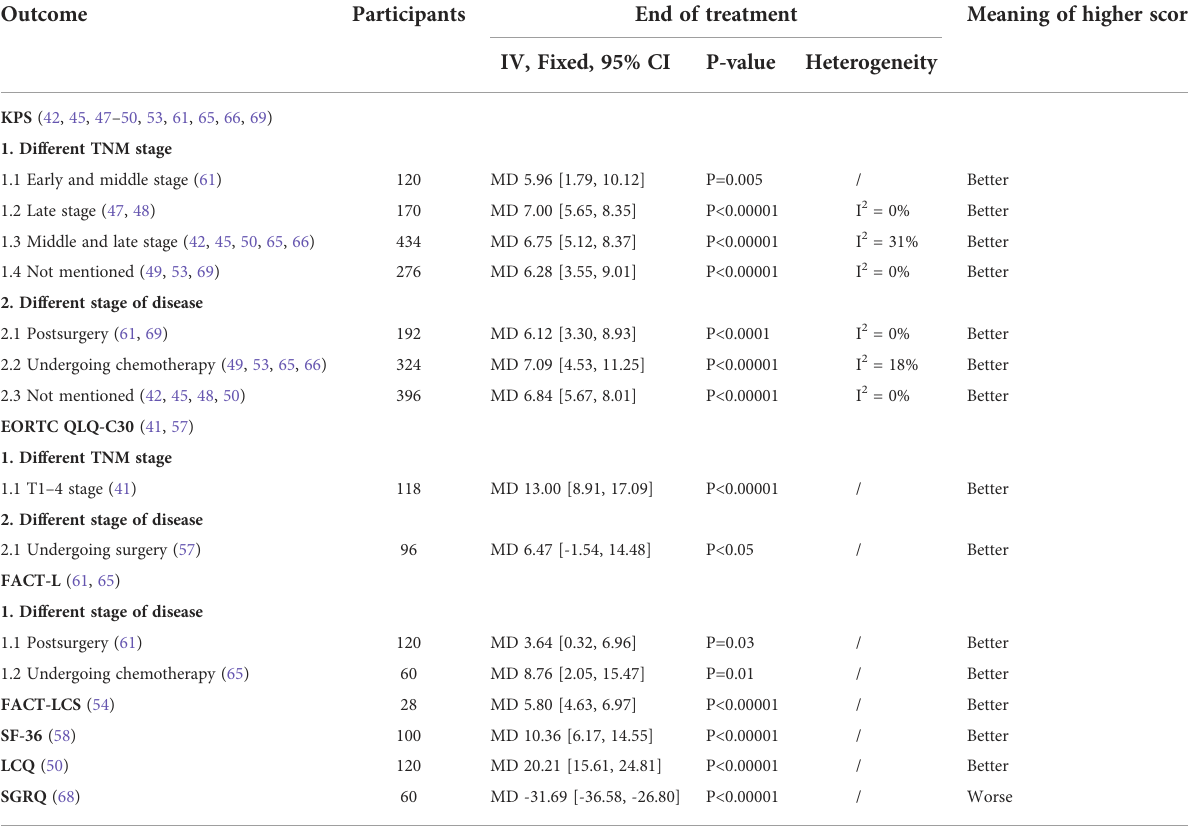
TABLE 1 The QOL of acupuncture with continuous variables versus comparators for lung cancer treatment – related